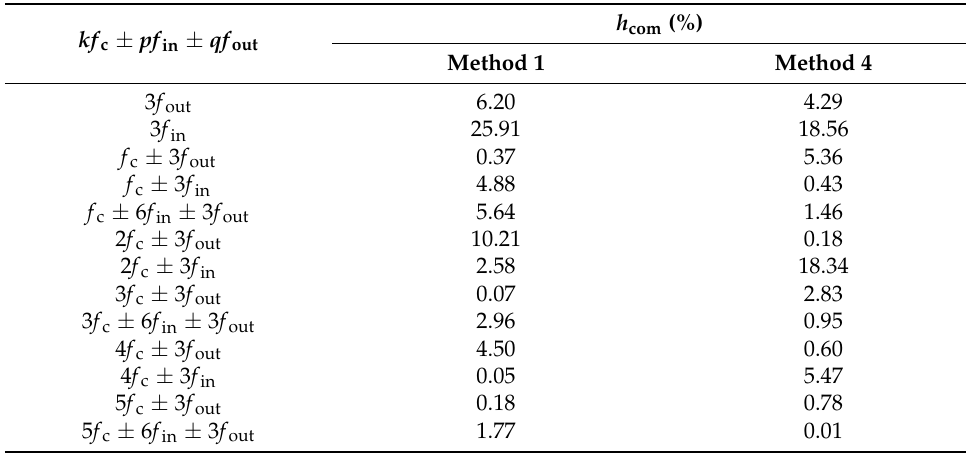
Figure 12. Maximum peak values of common-mode components at different frequency bands.